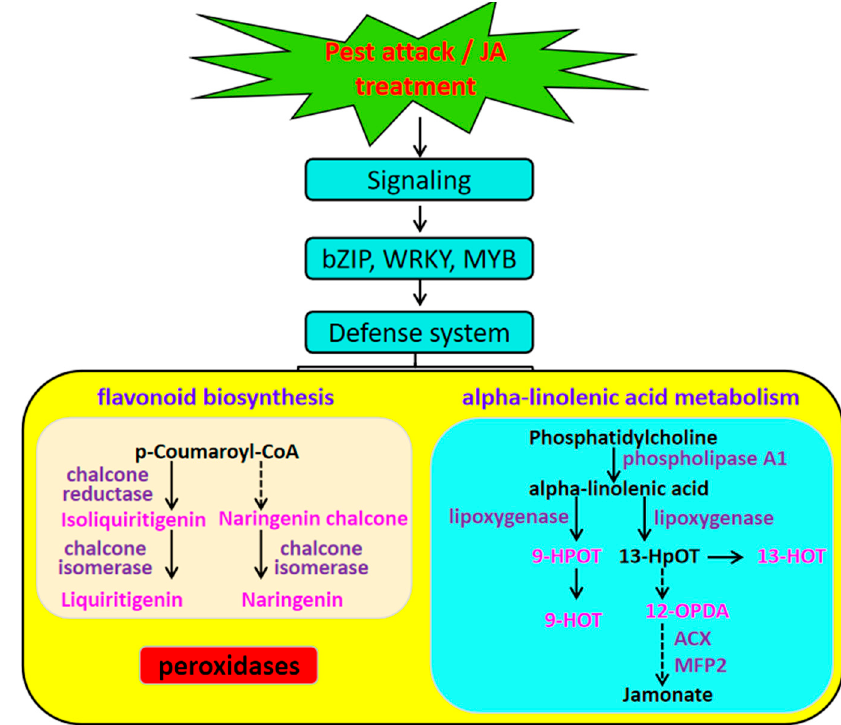
Figure 8. Putative model of cowpea’s response to Megalurothrips usitatus herbivory. The names in red are metabolite compounds. The DEGs are exhibited in purple below the arrows. 9-HPOT: 9- hydroxy-10E,12,15Z-octadecatrienoic acid; 9-HOT: 9-hydroxy-10,12,15-octadecatrienoic acid; 13-HOT: 13S-hydroxy-9Z,11E,15Z-octadecatrienoic acid; 12-OPDA: 12-oxo-phytodienoic acid; ACX: acyl-CoA oxidase; MFP2: enoyl-CoA hydratase/3-hydroxyacyl-CoA dehydrogenase. WRKY and MYB were the transcription factors identified in our study; however, their interaction with the downstream gene was unclear. The signaling is the common complex path triggered by the external stimulus.